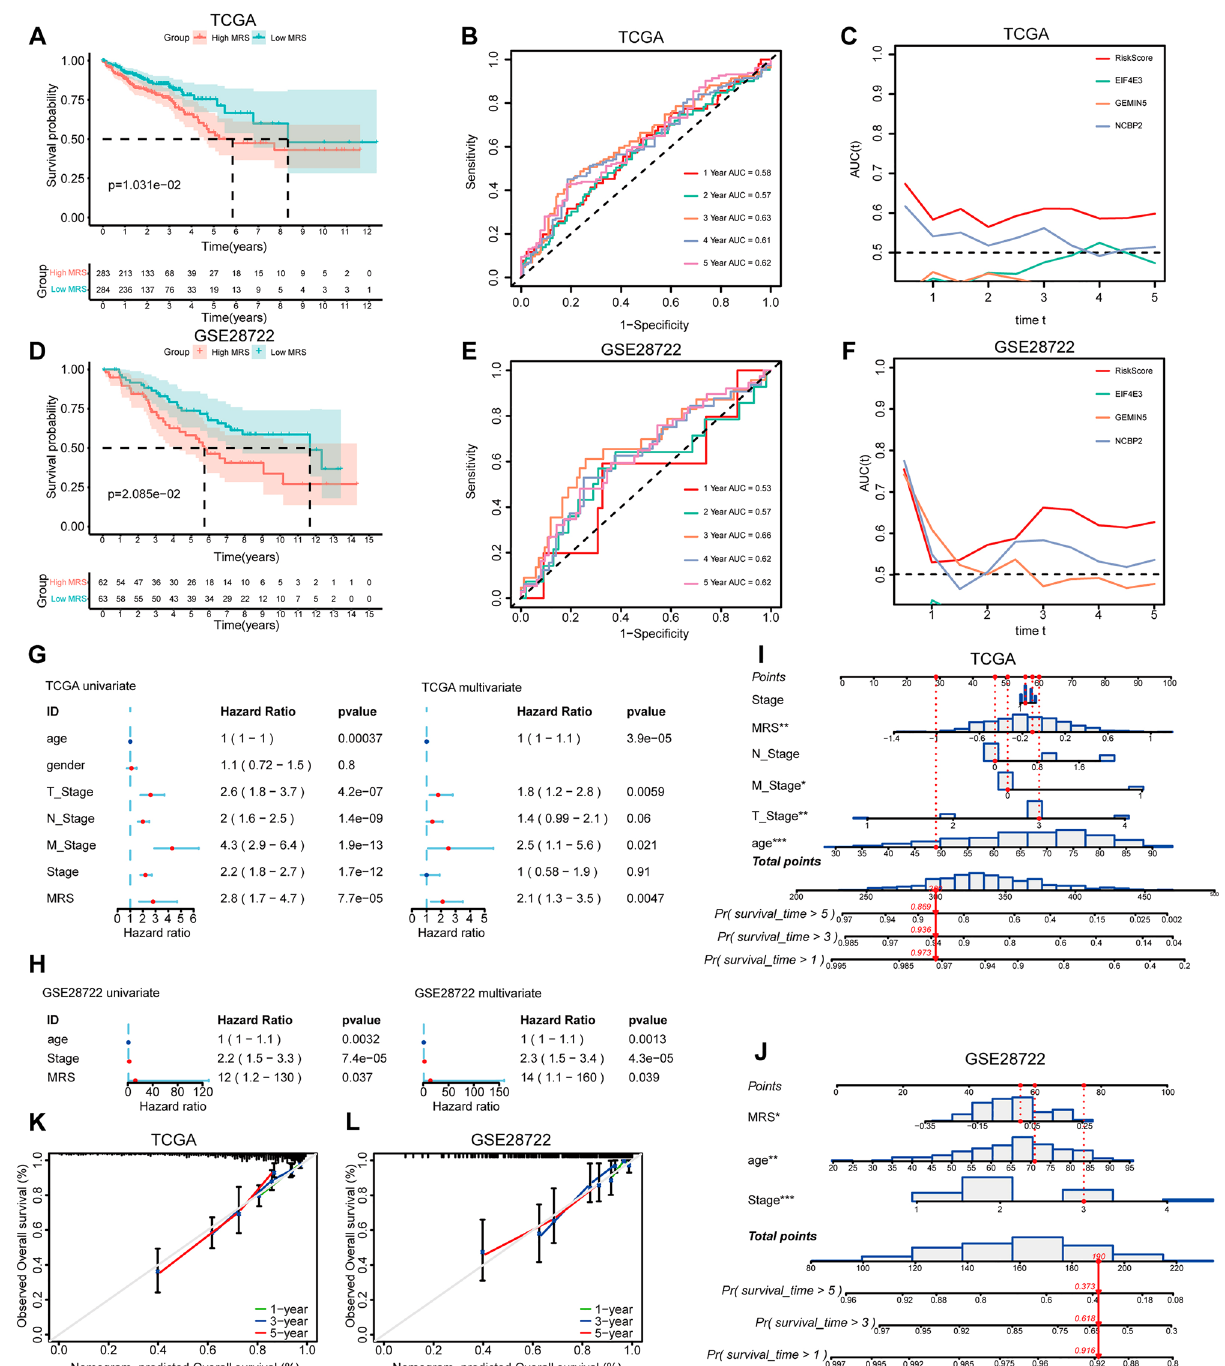
Figure 3. MRS model validation. ( A – C ) The training dataset was analyzed using Kaplan–Meier ( A ), ROC ( B ), and Time-ROC curves ( C ). ( D – F ) The validation dataset was analyzed using Kaplan–Meier ( D ), ROC ( E ), and Time–ROC curves ( F ). Univariate and multivariate Cox regression analyses were performed for MRS values in the training ( G ) and validation datasets ( H ). An MRS-based nomogram was constructed for the training ( I ) and validation datasets ( J ), with corresponding 1-, 3-, and 5-year calibration curves for these nomograms in the training ( K ) and validation datasets ( L ). *P < 0.05; **P < 0.01; ***P <